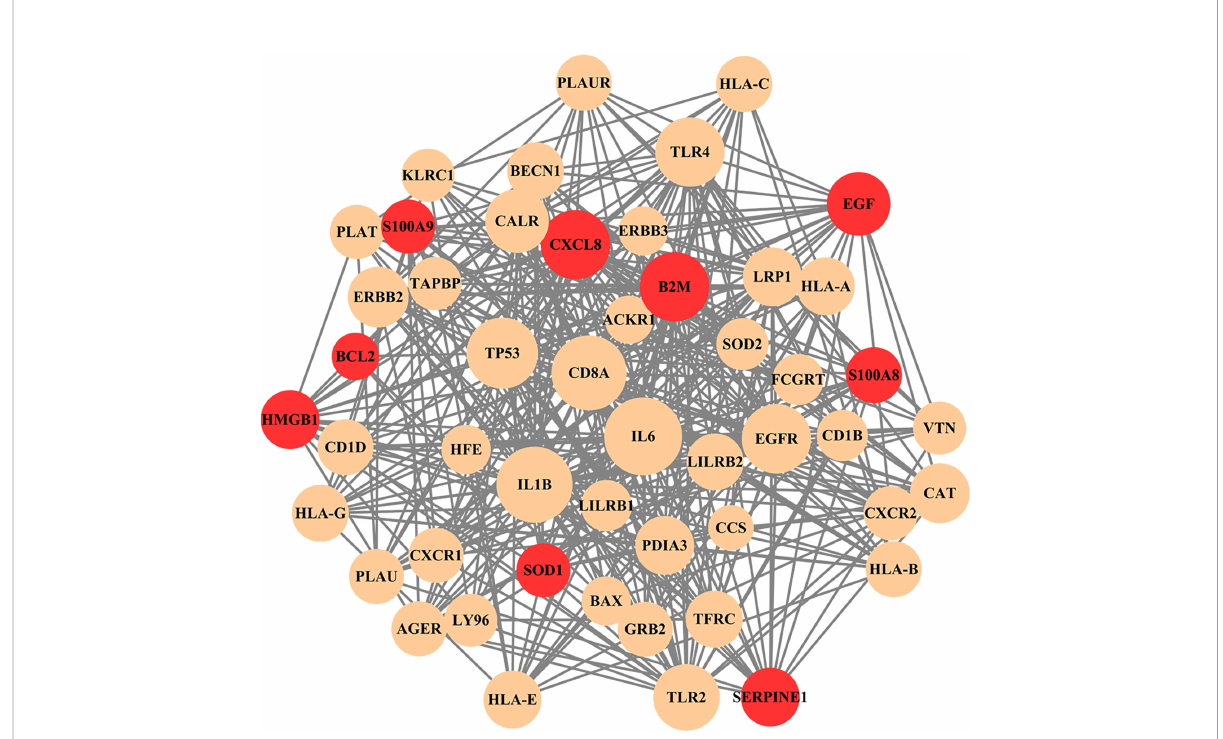
FIGURE 5 PPI network of common genes among long COVID and ME/CFS. In the fi gure, nodes in red color represent common genes and edges represent the interactions between nodes. The analyzed network holds 50 nodes and 375